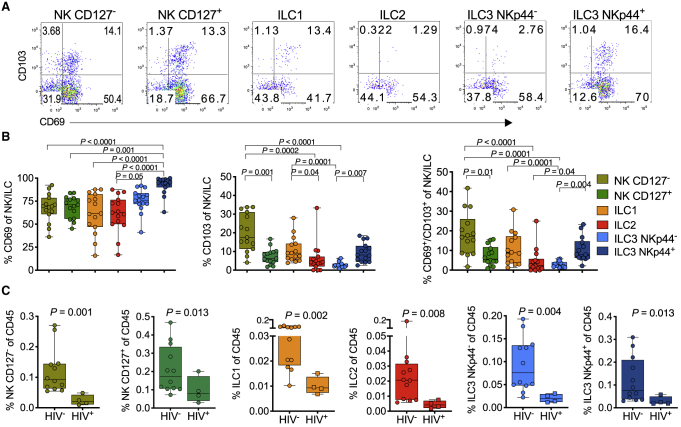
Lymphoid Tissue-Resident ILCs Are Reduced in the Tonsils of HIV-Infected Children(A) Gating of CD69 and CD103 co-expression from each of the six innate subsets as indicated above flow plots (see Figure S3).(B) Frequencies of CD69 (left), CD103 (center), and combined CD69/CD103 (right) expression on six innate tonsil NK/ILC cell populations as defined in (A) in 15 pediatric subjects. p values by Dunn’s multiple comparisons test.(C) Frequencies of each of the six innate lymphocyte population in tonsils, comparing pediatric HIV-uninfected (HIV−; n = 12) and HIV-infected (HIV+; n = 4) subjects. (See also Figure S3). P values by Mann-Whitney U test.